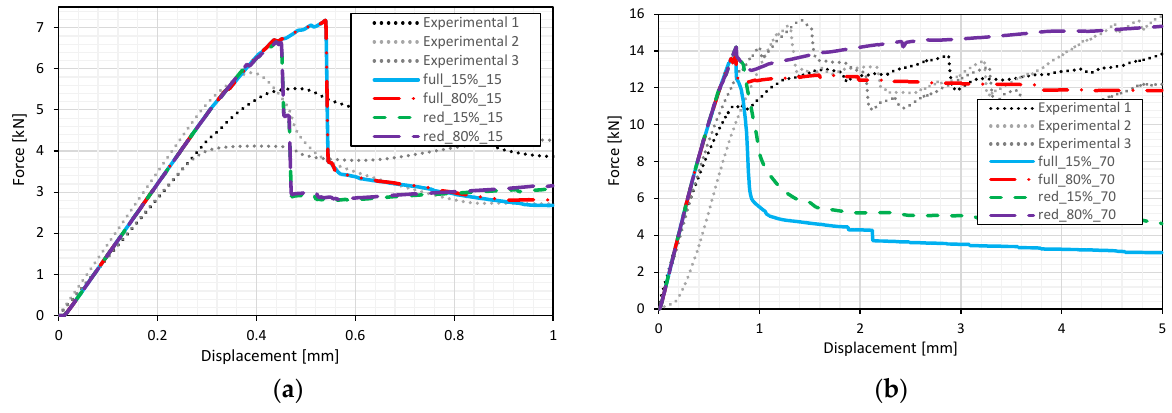
Figure 17. Force vs. displacement for ( a ) 15 mm cover and ( b ) 70 mm cover for the double-lap test.